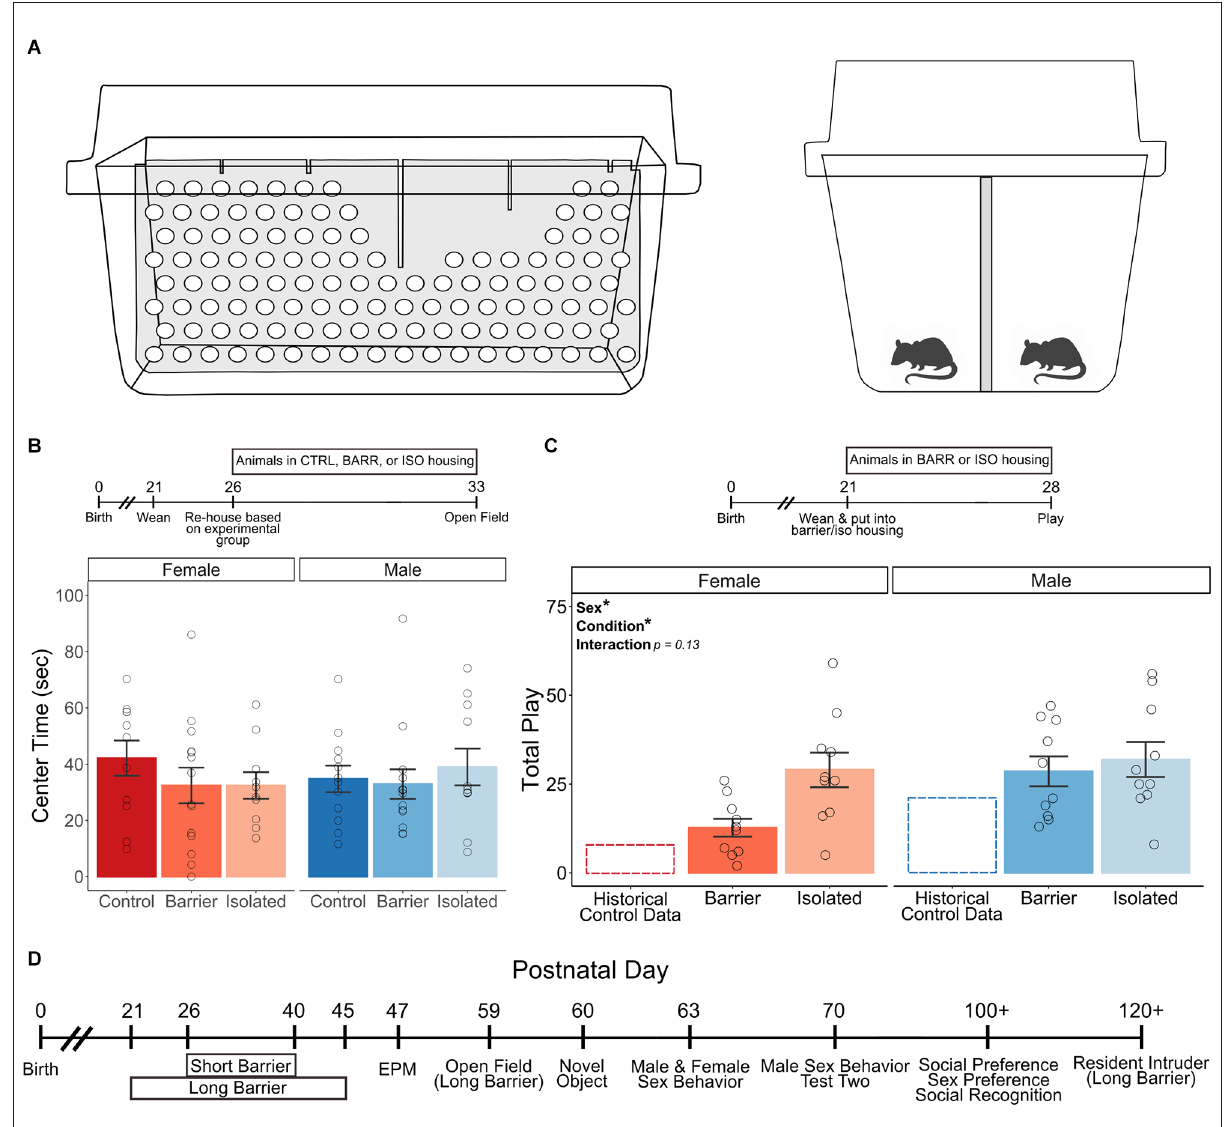
FIGURE1 Experimental approach and assessment of acute effects of barrier separation/isolation. Cartoons depicting the perforated Plexiglass cage divider (in light gray) used to prevent play in BARR animals (A) , viewed from the side (left panel, no animals shown) and straight on (right panel). Acute play deprivation has no effect on anxiety-like behavior as evidenced by center time in an open field test (B) , with timeline of experiment shown above graph); additionally, the ability and motivation to engage in play is maintained ( C , showing the intact play in BARR and ISO animals of both sexes compared to historical control data, with timeline of experiment shown above graph). A timeline of experimental procedures for the remainder of the study is shown in (D) . All behavioral tests shown on the timeline were conducted in both the short and long duration barrier studies unless otherwise noted. Bars indicate group means ± SEM, and open circles represent data from individual rats. * p < 0.05, n = 10–14 per